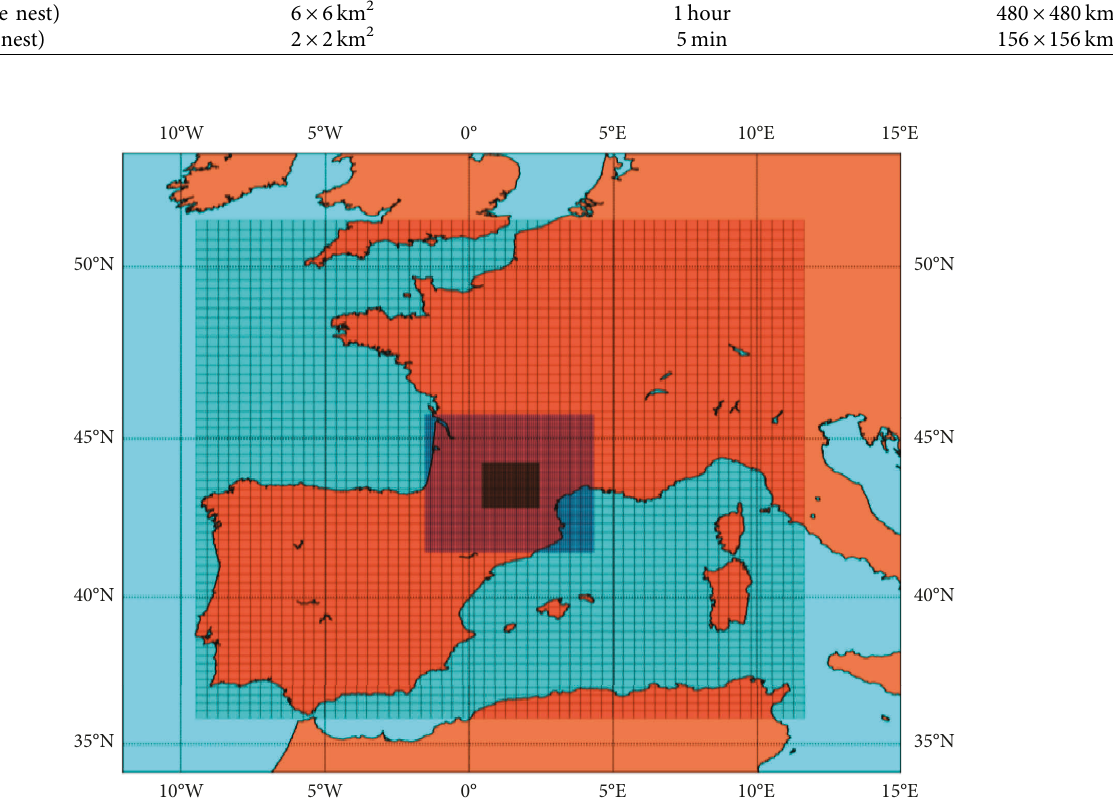
Figure 2: Illustration of the three nested geographical domains of the WRF-ARW